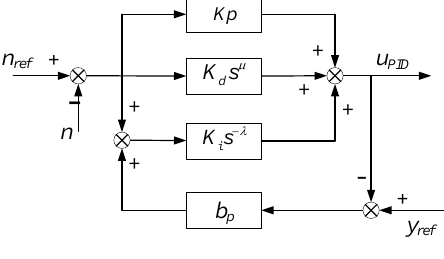
Figure 7. Structure diagram of the PI λ D µ